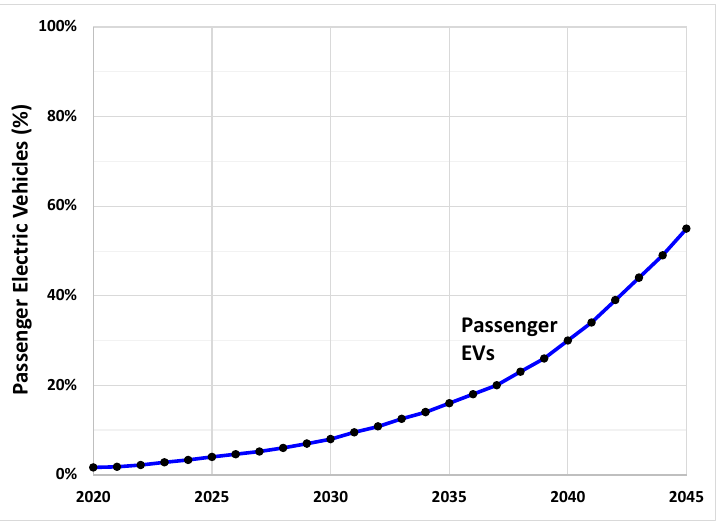
Figure 12. Passenger EV adoption based on Hawaiian Electric Companies’ projection to gradually reach 55% passenger EVs on the road by 2045.